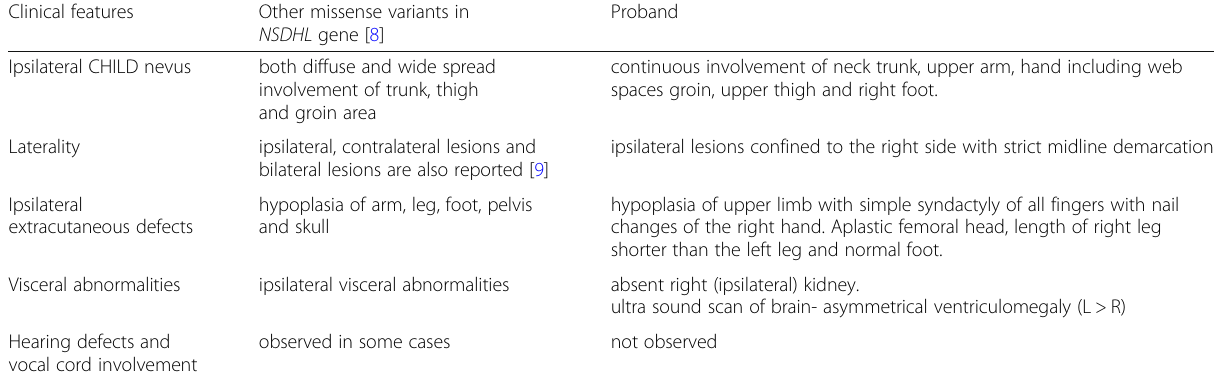
Table 1 Comparison of clinical data of missense variants in NSDHL gene Clinical